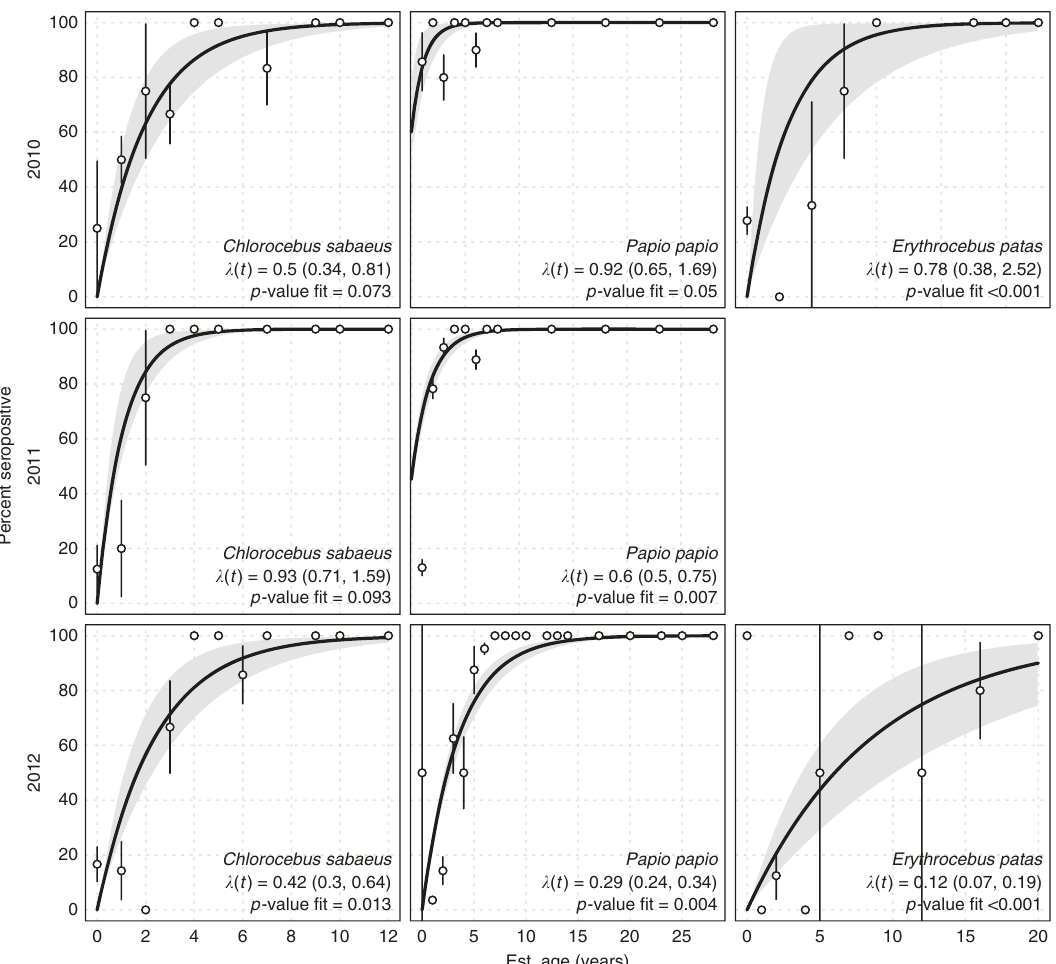
Fig. 5 Forces of infection by species and year. Panels show the forces infection ( λ ( t )) and p -values (Chi-squared test comparing model to saturated model) for the fi t across years for C. sabaeus , E. patas , and P. papio , respectively. Too few E. patas were collected in 2011 to obtain estimates. We included all monkeys <1-year-old in the 0-age category (we present seropositivity results for monkeys under 3 years of age in Supplementary Fig. 4). Points are the proportion of seropositve monkeys per age year with con fi dence intervals. Thick black line is the fi t of the force of infection, gray bands are bootstrap con fi dence intervals for the fi